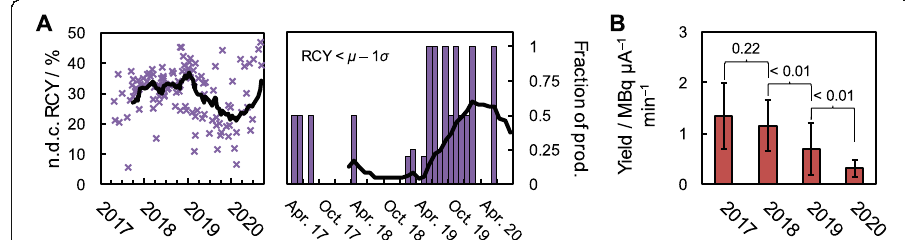
Fig. 2 Temporal evolution of the radiochemical yields at HUH and AUH. A Non-decay corrected RCYs for the individual productions of [ 18 F]1 at HUH as function of production date (left), and the fraction of the productions in any given month furnishing RCYs more than one standard deviation below the mean over the entire time period considered (right). In both figures, the bold line gives the moving average with a period of 12. B The annual mean radiochemical yield of [ 18 F]1 at AUH given in units of MBq μ A min − 1 in order to compare productions with differences in target current and irradiation time. The numbers indicate the calculated p